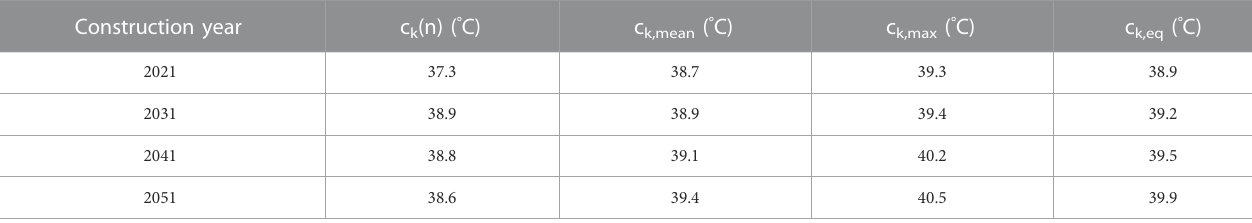
TABLE 2 Non-stationary characteristic values for the presented example using Eqs 1 –